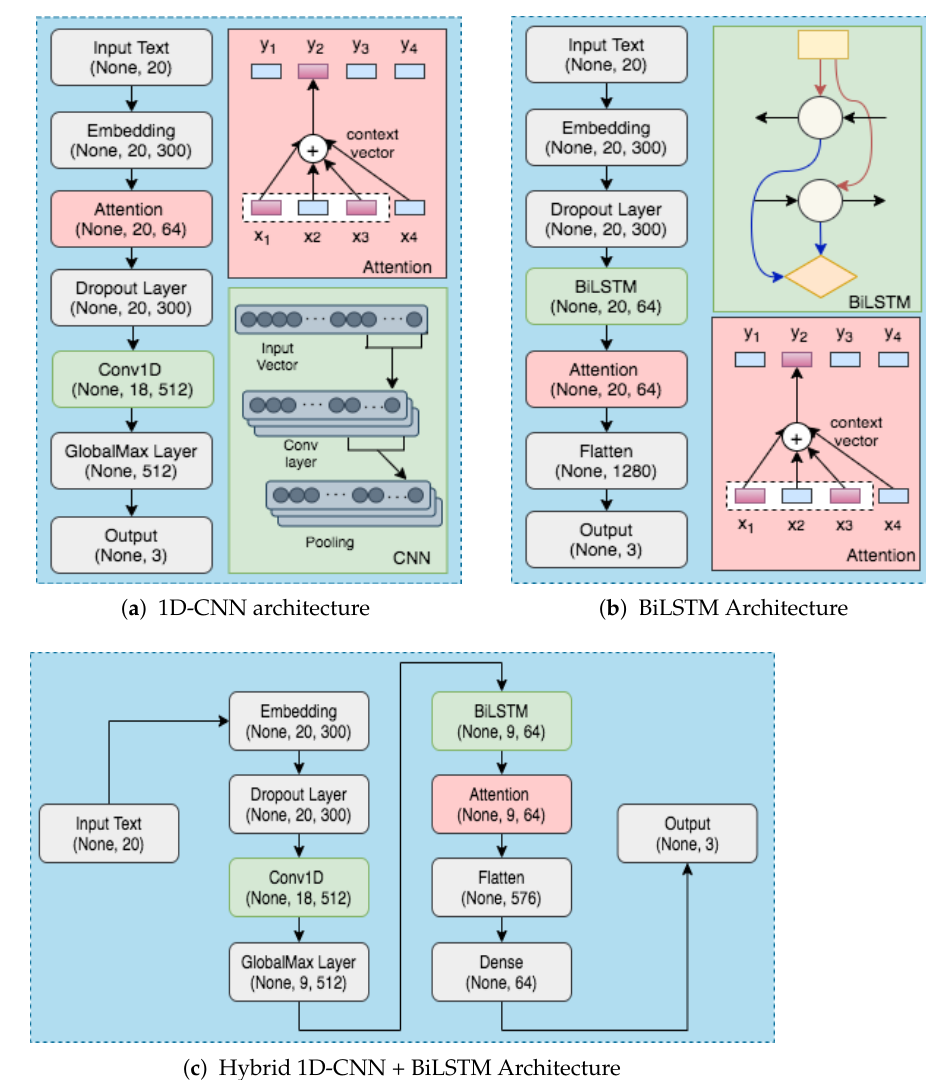
Figure 6. Deep neural networks used for sentiment classification.